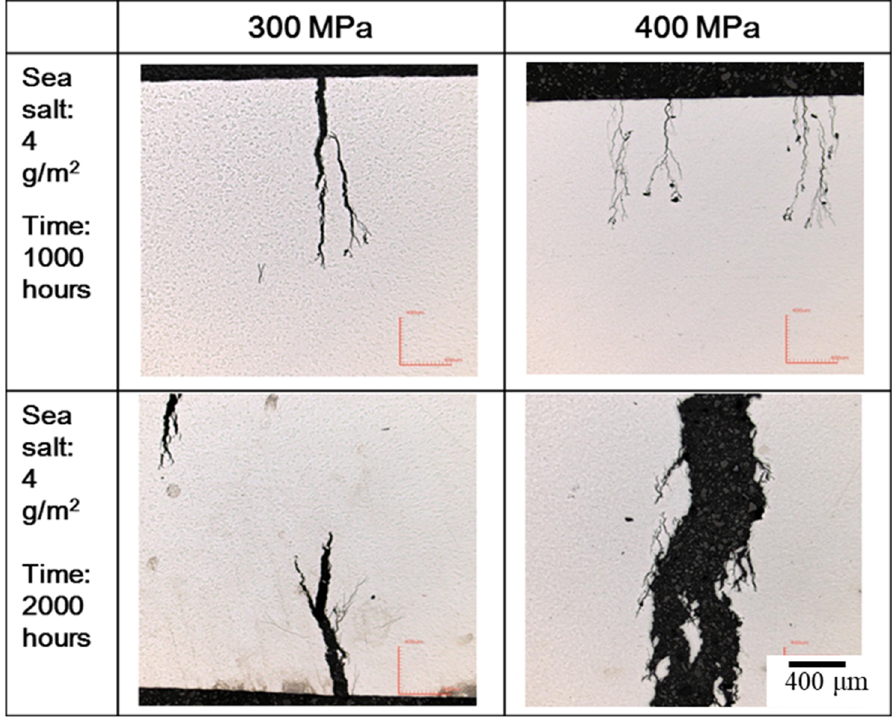
Figure 6. The crevice corrosion specimens with 4 g/m 2 of sea salt deposited on the surface were subjected to tensile stresses of 300 MPa and 400 MPa at a temperature of 45 °C.